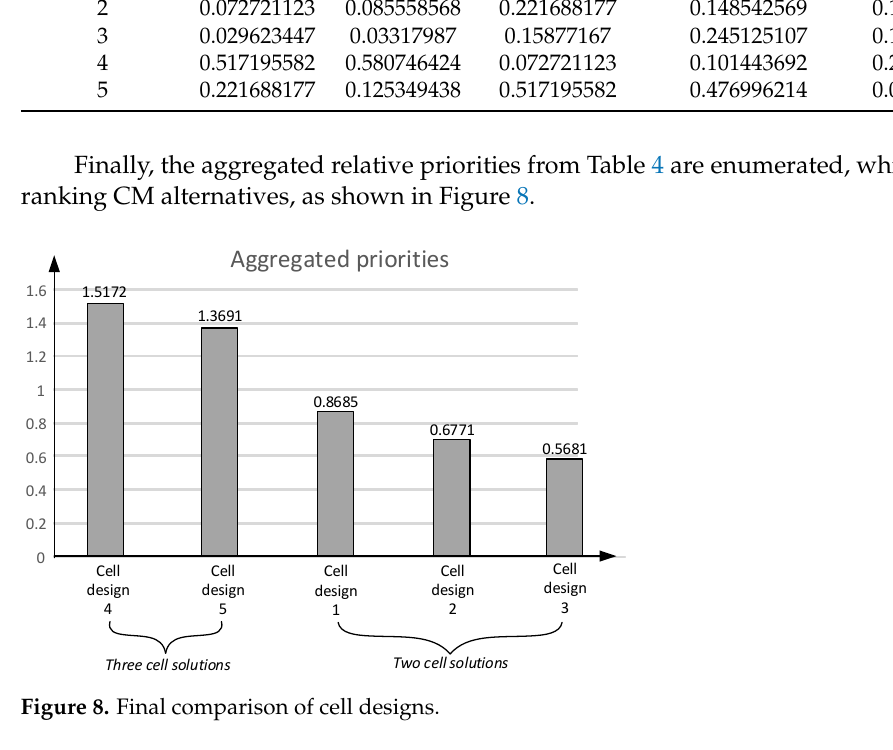
Table 4. Obtained priority vectors values for all the criteria.